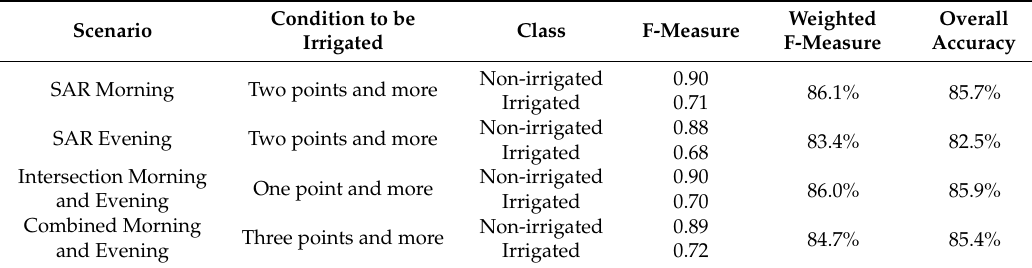
Table 3. The values of the overall accuracy and F-measure obtained for classification of irrigated and non-irrigated plots using the detected irrigation points for four di ff erent scenarios.